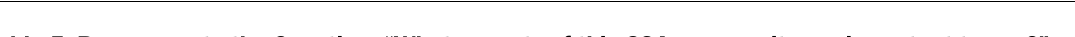
Table 5. Responses to the Question, “What aspects of this CSA community are important to you?”